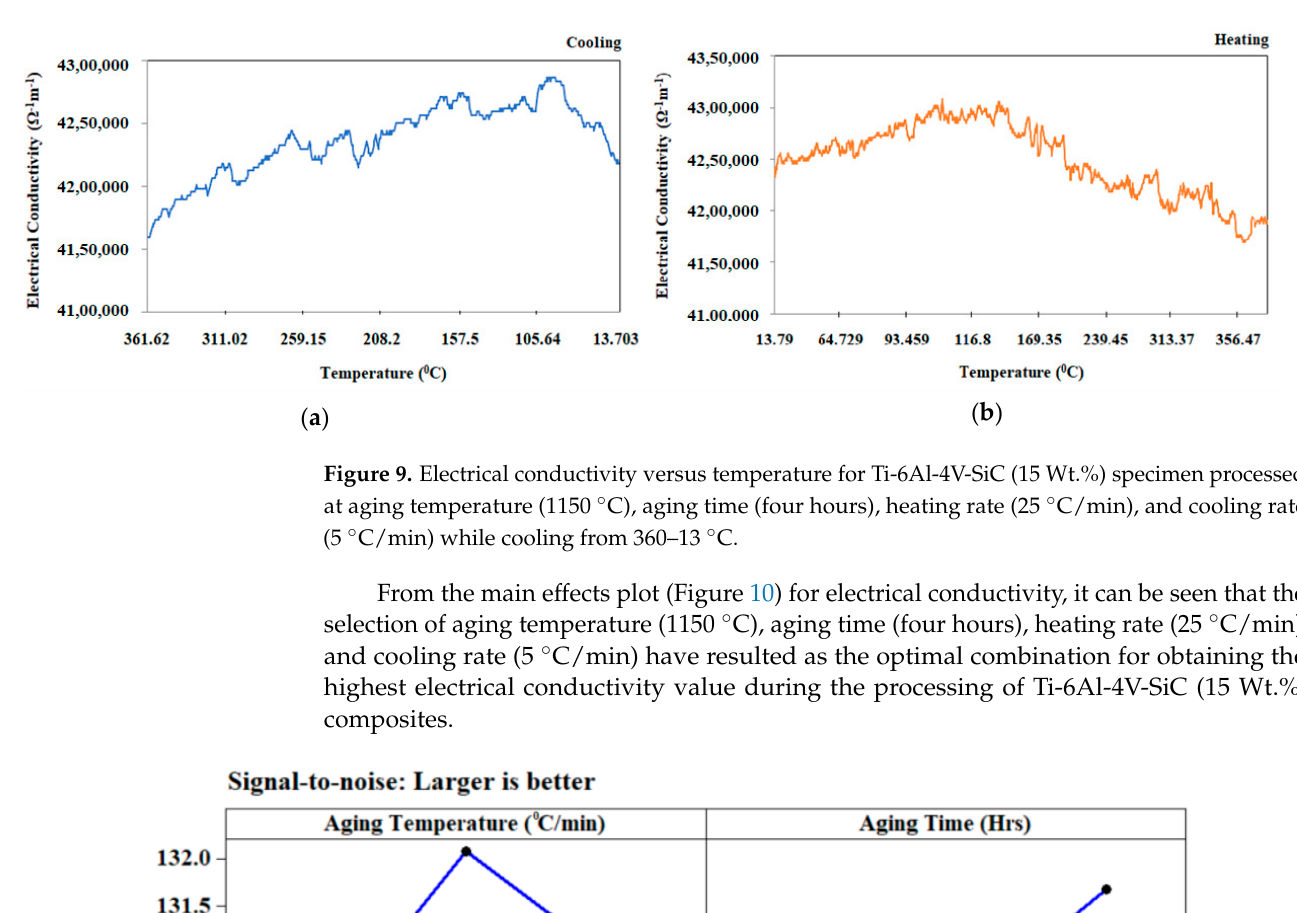
Figure 11. XRD Peaks of Ti-6Al-4V-SiC(15 Wt.%) processed under aging temperature (1150 °C), aging time (four hours), heating rate (5 °C/min), and cooling rate (5 °C/min). The second order model (Equation (12)) which has been generated using response surface methodology for electrical conductivity can be expressed as a “function of pro- cessing parameters” such as aging temperature (°C), aging time (h), heating rate (°C/min) and cooling rate (°C/min) as shown in Equation (6) from the coefficients of re- gression estimated (Table 10). Electrical Conductivity ( Ω − 1 m − 1 ) = 3 ,825,280 + 134,444 A + 153,333 B + 16,667 C + 321,667 D − 774,773 A 2 + 305,227 B 2 + 75,227 C 2 + 80,227 D 2 + 26,250 AB − 18,750 AC + 53,750 AD − 18,750 BC + 13,750 BD − 18,750 CD